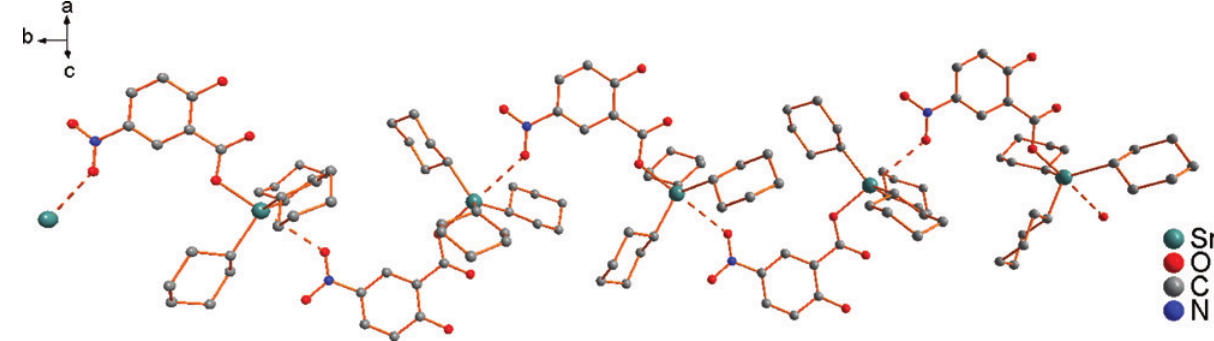
Figure 4: The zigzag chain of 2 formed by the intermolecular Sn···O interaction.